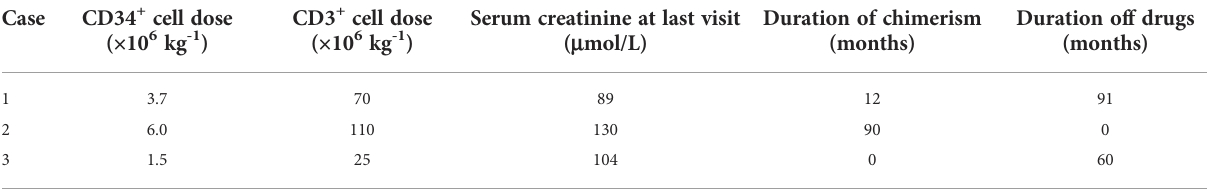
TABLE 1 Mononuclear cell infusion dose and follow-up